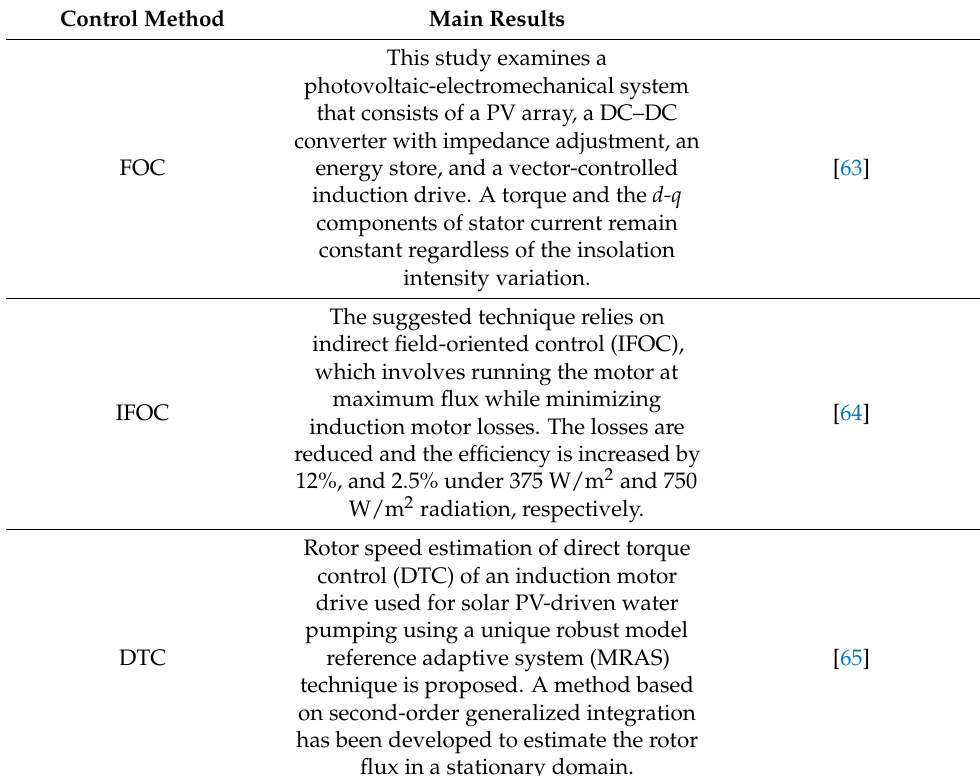
Table 7. Application of different drive control methods for SWPPs.